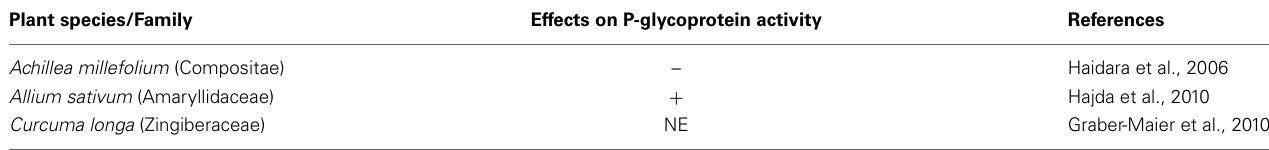
Table 9 | Medicinal plant species listed in RENISUS with reported effects of on P-glycoprotein activity. Plant species/Family Effects on P-glycoprotein